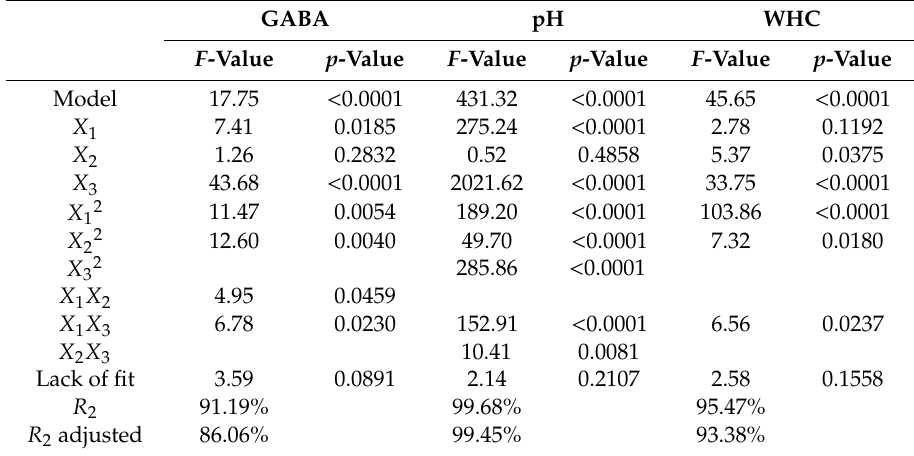
Table 2. Analysis of variance (ANOVA) for the full quadratic model of GABA content, pH, and water-holding capacity obtained during